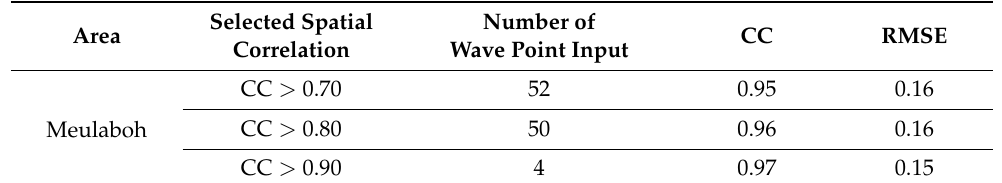
Figure 14. Spatial correlation maps at Meulaboh offshore, obtained by calculating the correlation coefficient (CC) between Hs at the global grid with Hs at a targeted local domain. Big dots denote CC values: in the upper plot for CC values ≥ 0.70, the lower plot for CC values ≥ 0.80, and the lower plot for CC values ≥ 0.90. Table 5. Comparison between selected spatial correlation with results of downscaling performance for prediction 14 days ahead in Meulaboh